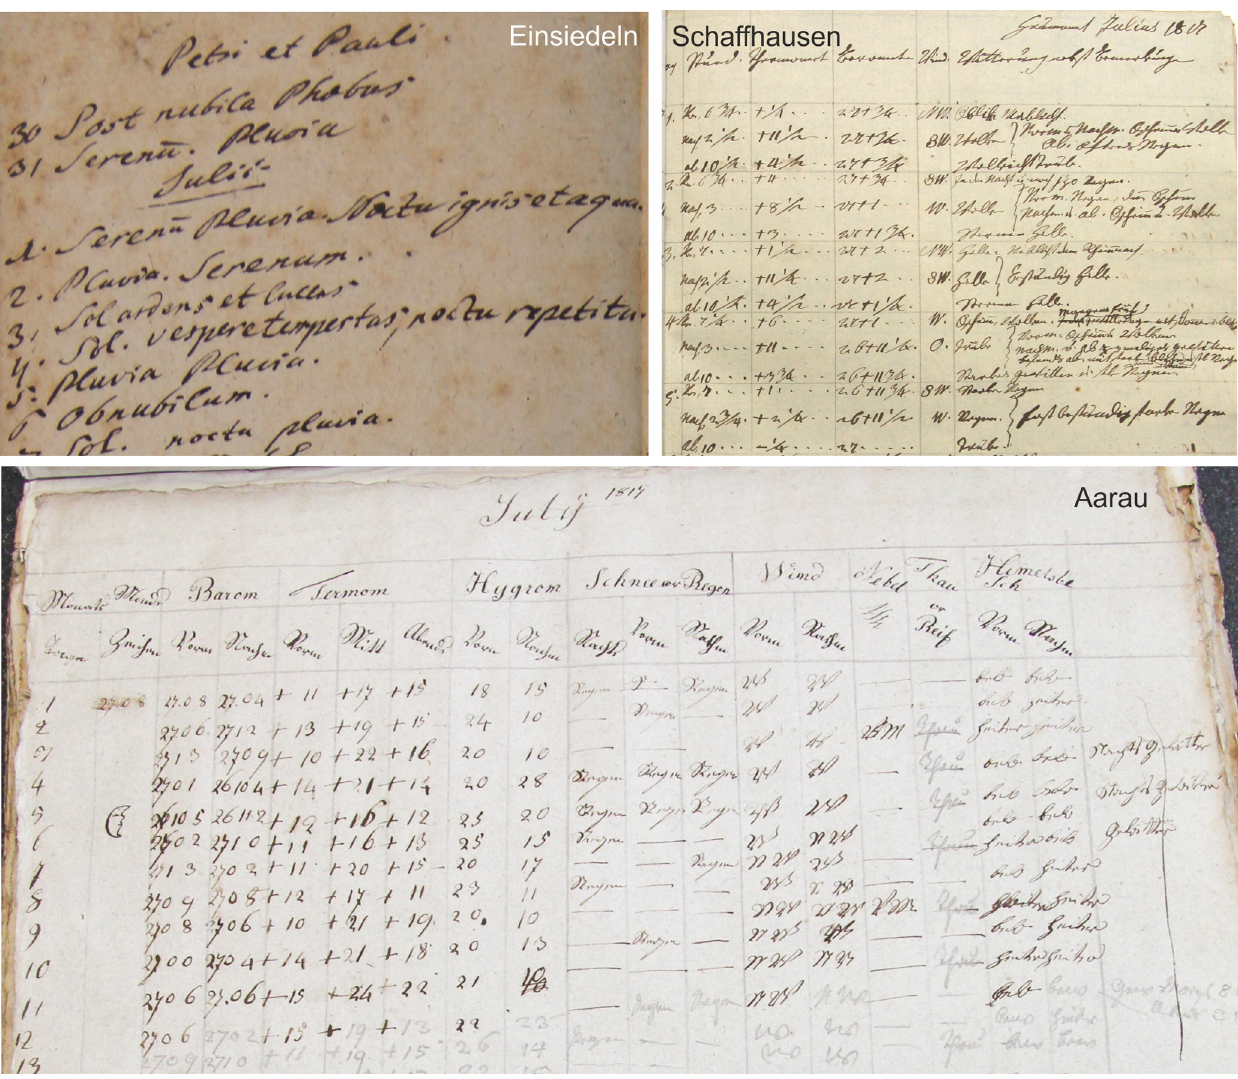
Figure 7. Excerpts of data sheets from Einsiedeln, Schaffhausen, and Aarau for early July 1817 (Klosterarchiv Einsiedeln: KAE.A.39/6; Swiss Federal Archives: E3180-01#2005/90#201 ∗ ; State Archives Aargau: